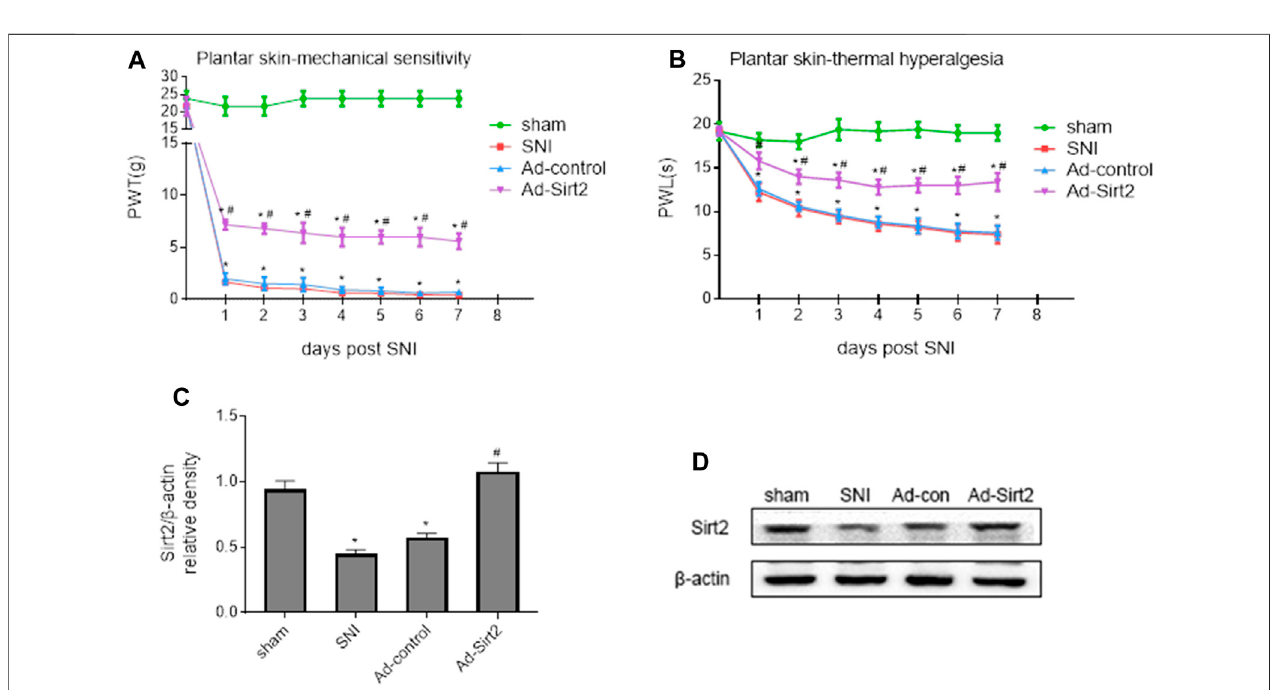
FIGURE 7 | (A,B) : Effects of intrathecal injection of a recombinant adenovirus expressing Sirt2 and GFP (Ad-Sirt2) or control and GFP (Ad-control) on mechanical allodynia and thermal hyperalgesia in SNI rats. (C,D) : Effects of intrathecal injection of Ad-Sirt2 or Ad-control on expression of Sirt2 in the spinal cord of SNI rats. Sham ratswithouttreatmentservedascontrol.Valuesareexpressedasmean ± SE(n (cid:1) 5foreachgroup).* p < 0.05vsshamorbaseline(day0); # p < 0.05vsSNIorAd-control.